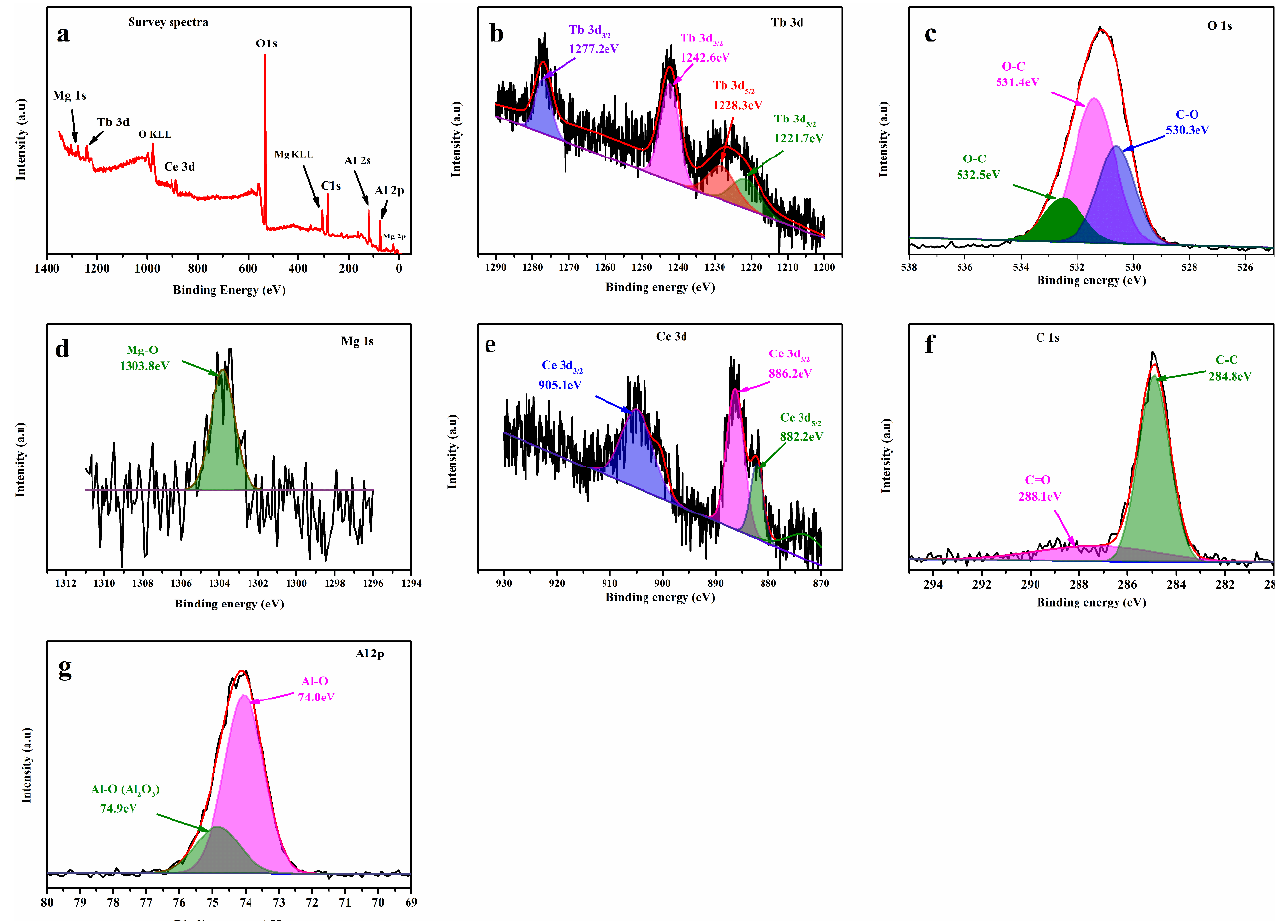
Figure 4. XPS spectra of CMAT, ( a ) survey spectra, ( b ) Tb3d, ( c ) O1s, ( d ) Mg1s, ( e ) Ce3d, ( f ) C1s, and ( g ) Al2p.